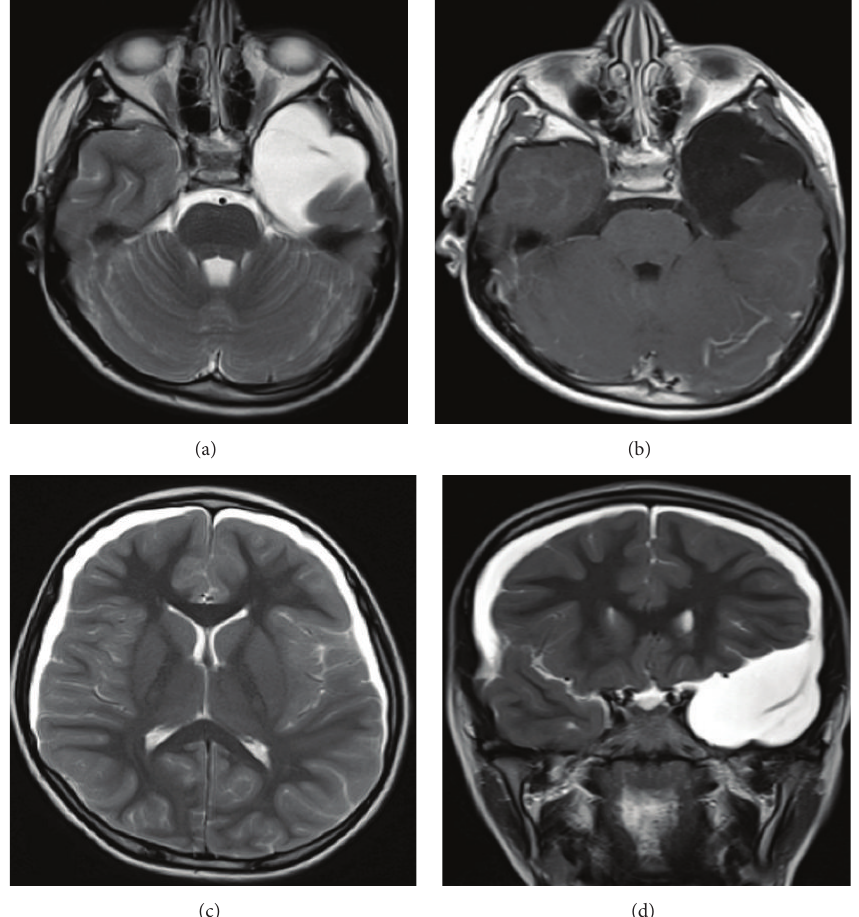
Figure 1: MRI brain axial T2 and T1 weighted postcontrast images (a) and (b) showing an extra-axial fluid signal intensity lesion in the left temporal region without any solid component or abnormal enhancement. Axial and coronal T2 weighted images show bilateral frontoparietal crescent shaped subdural fluid